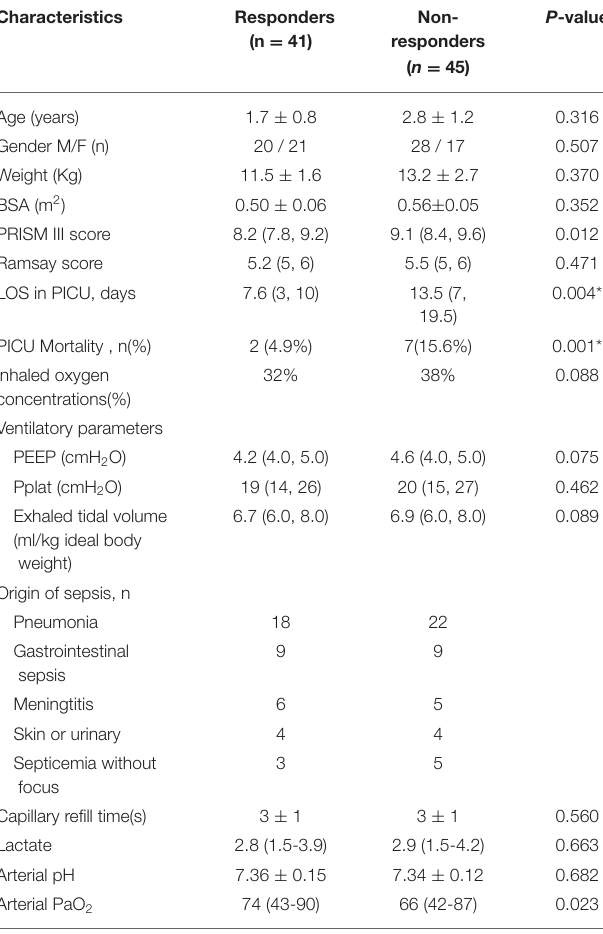
TABLE 2 | Comparison of hemodynamic parameters before and after volume expansion. Variables Before